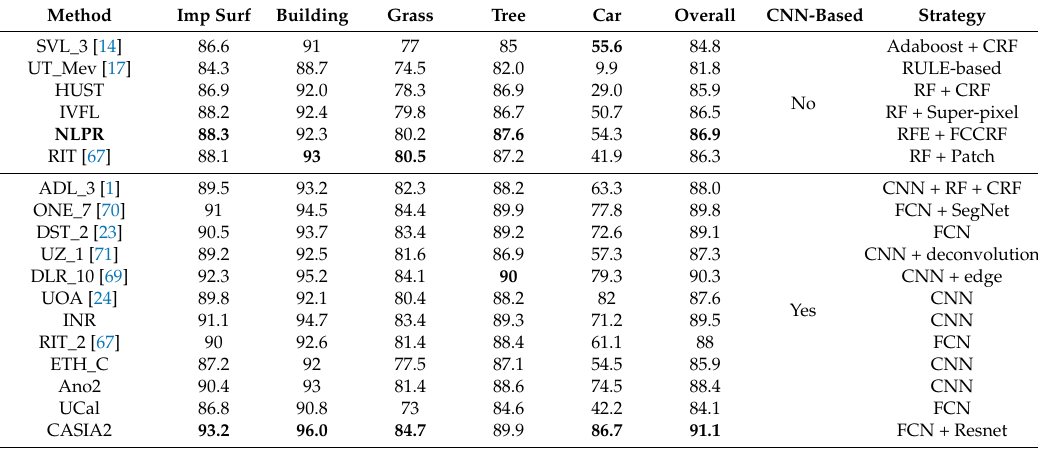
Table 5. Comparison with the best results achieved by each research group in the ISPRS Semantic Labeling Contest. Our method is denoted as “NLPR”.